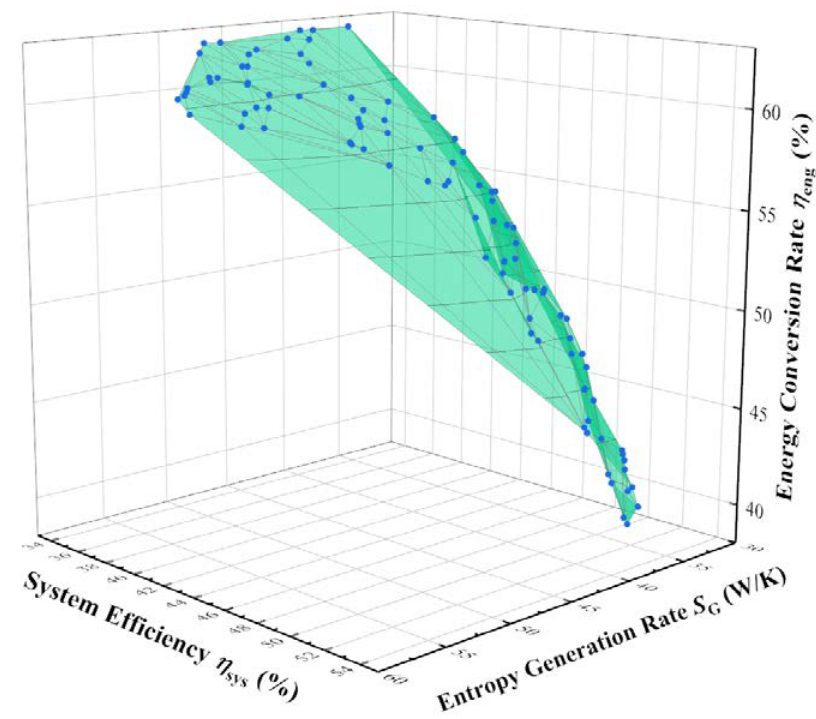
Figure 5. Pareto Front of three-objective optimization at 800 W/m 2 .